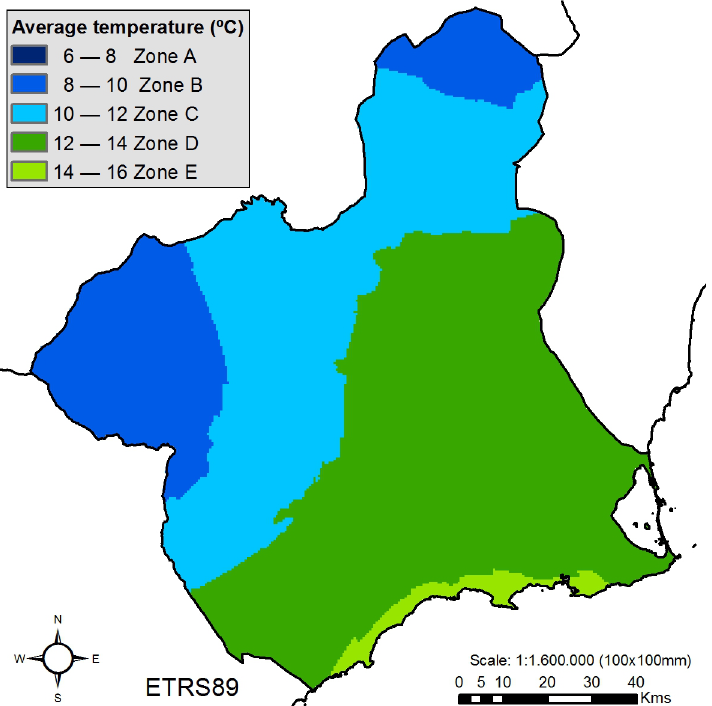
Figure 7. Climatic classification of the stone fruit tree producing areas in the Murcia